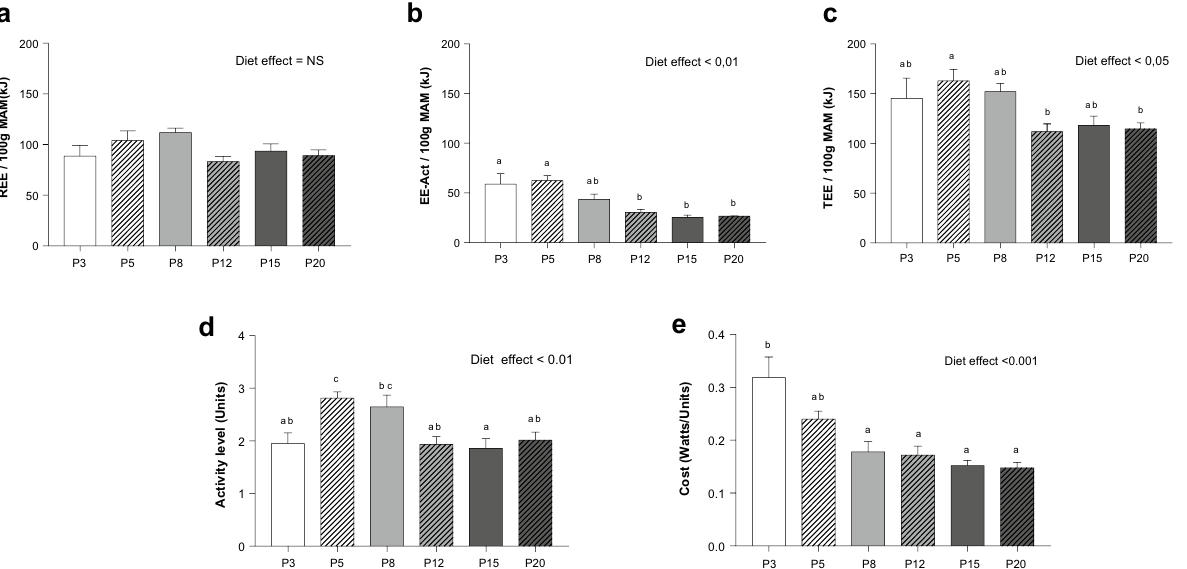
Figure 2. Component of energy expenditure in ad libitum-fed rats: resting energy expenditure ( a : REE), energy expenditure of motor activity ( b : EE—Act), total energy expenditure ( c : TEE), activity level ( d ) and cost of activity ( e ). Values are means ± SEM (n = 6 per group). a,b,c,d Data that do not share the same letter are different at the P < 0.05